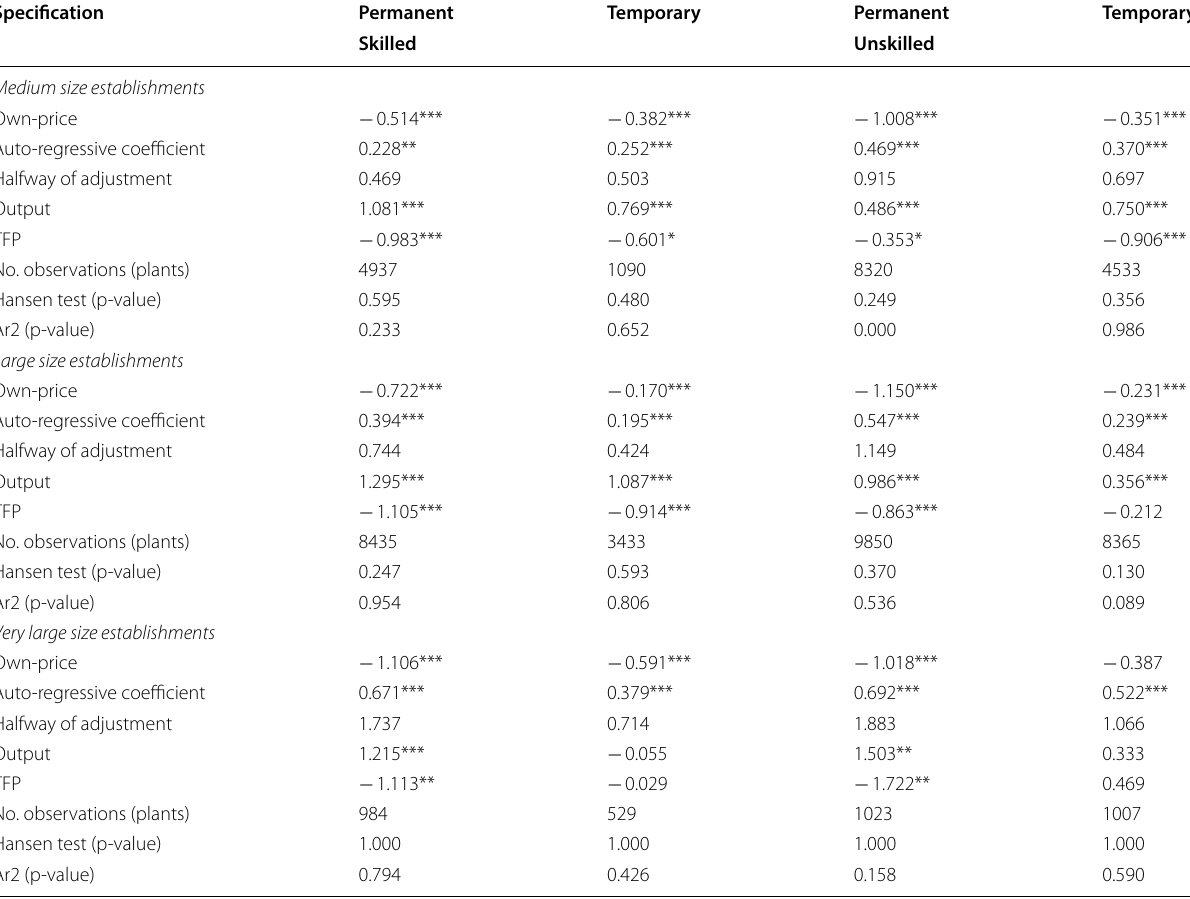
*, **, *** Correspond to 10%, 5% and 1% level of significance, respectively. Hansen test refers the accuracy of the set of instruments; the Ar2 test shows that the errors do not exhibit autocorrelation of order